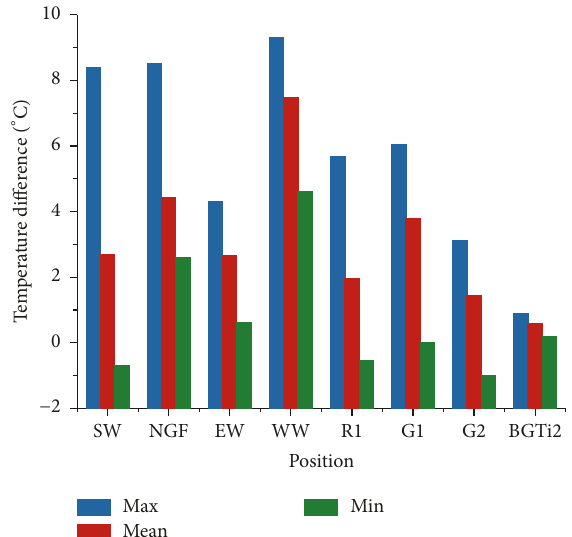
Figure 12: Difference of air temperature from the inner surface temperature of the building envelope and black globe temperature.